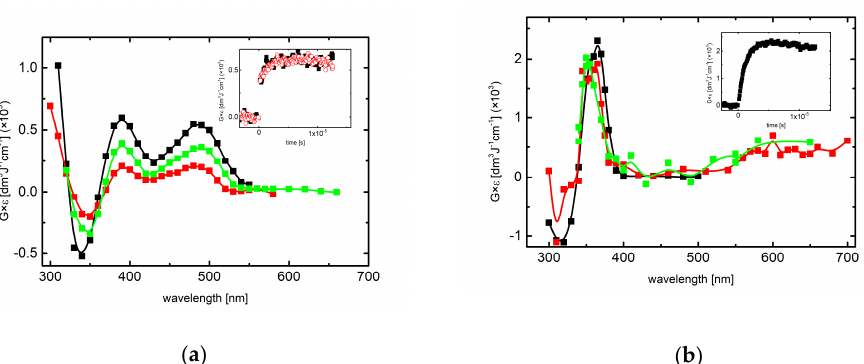
Figure 3. ( a ) Transient absorption spectra recorded in Ar-saturated aqueous solutions containing 0.1 mM 7-R-3-MeQ (R = —CN ( ■ ), —CF 3 ( ■ ), —F ( ■ )) 0.1 M K 2 S 2 O 8 and 0.5 M tert -BuOH at pH 4, 6 μs, 7 μs, and 6 μs after the electron pulse, respectively; ( b ) Transient absorption spectra in N 2 O-saturated aqueous solutions containing 0.1 mM 7-R-3-MeQ (R = —CN ( ■ ), —CF 3 ( ■ ), —F ( ■ )) and 0.1 M NaN 3 at pH 7, 6 μs, 7 μs, and 8 μs after the electron pulse, respectively.